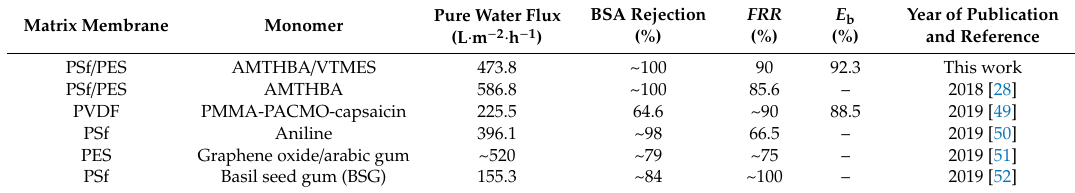
Table2. ComparisonofPSf / PES-AM-VTmembranesdevelopedinthepresentstudywithothermembranes. Matrix